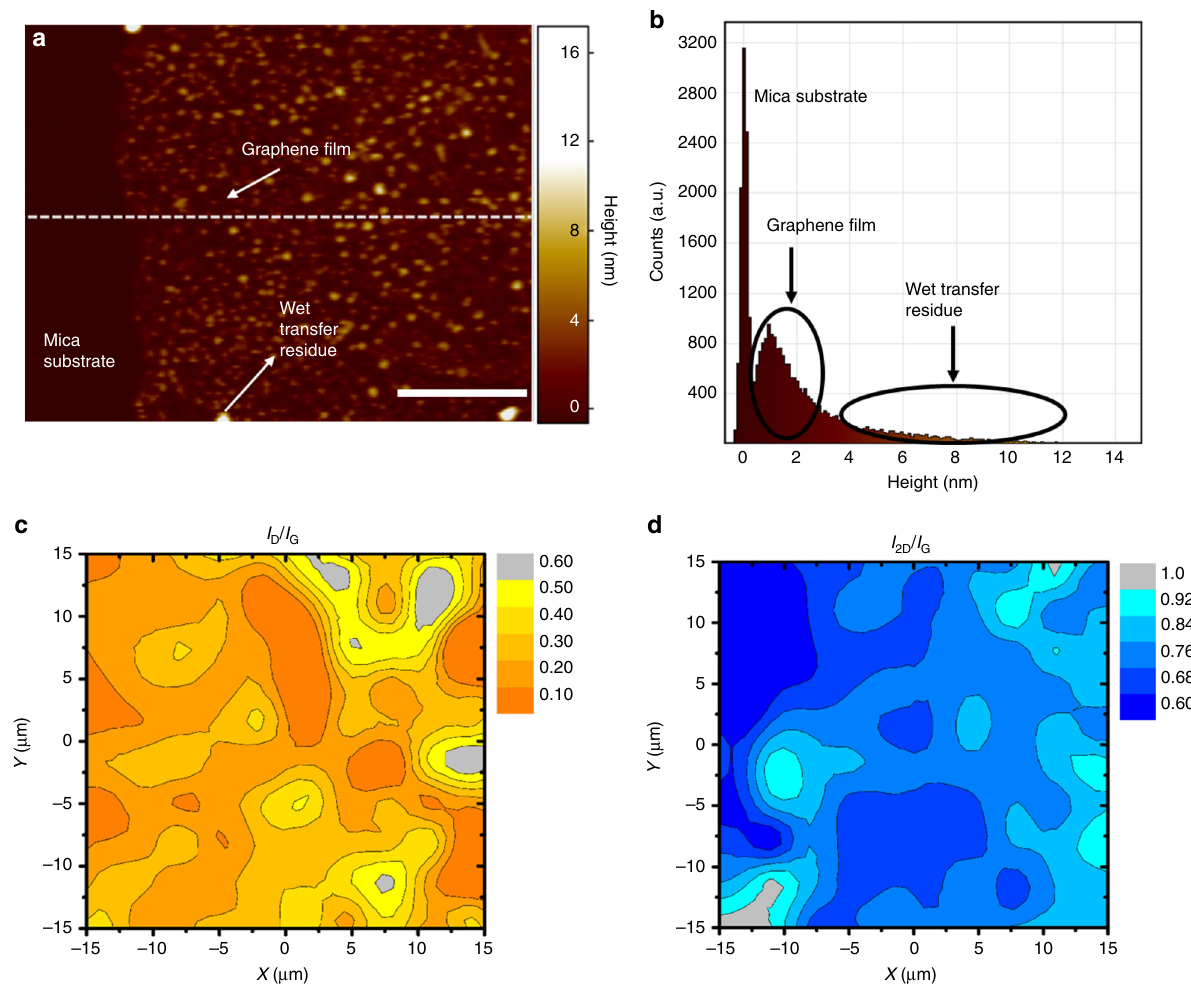
Fig. 4 Additional structural features of permeable graphene fi lms. Additional characterisation of the graphene fi lms reveals their rough surface texture and variation in thickness. These features are favourable for generating a bottleneck region for water vapour permeation. The presence of multiple nanocrystalline domains suggests the existence of numerous channels for water vapour permeation. a An AFM topography image of the edge of a graphene fi lm deposited on a mica substrate; the dark region at the left hand side of the image is the mica substrate; the lighter region is the graphene fi lm; and the bright spots are most likely residue from the wet-transfer process; scale bar is 1 µ m. b A relative height histogram of the AFM image ( a ). The high narrow peak around 0 nm height represents the mica substrate, the broader distribution represents the graphene fi lm and the tail up to heights of 18 nm most likely represents wet-transfer process residue. c , d Raman spectral mapping analyses of the intensity ratios of I D /I G and I 2D /I